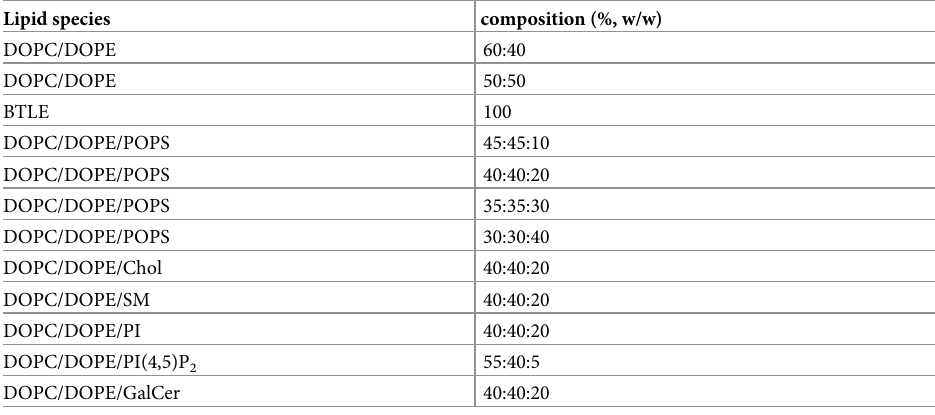
Table 1. Liposome compositions used for co-sedimentation assays. Lipid